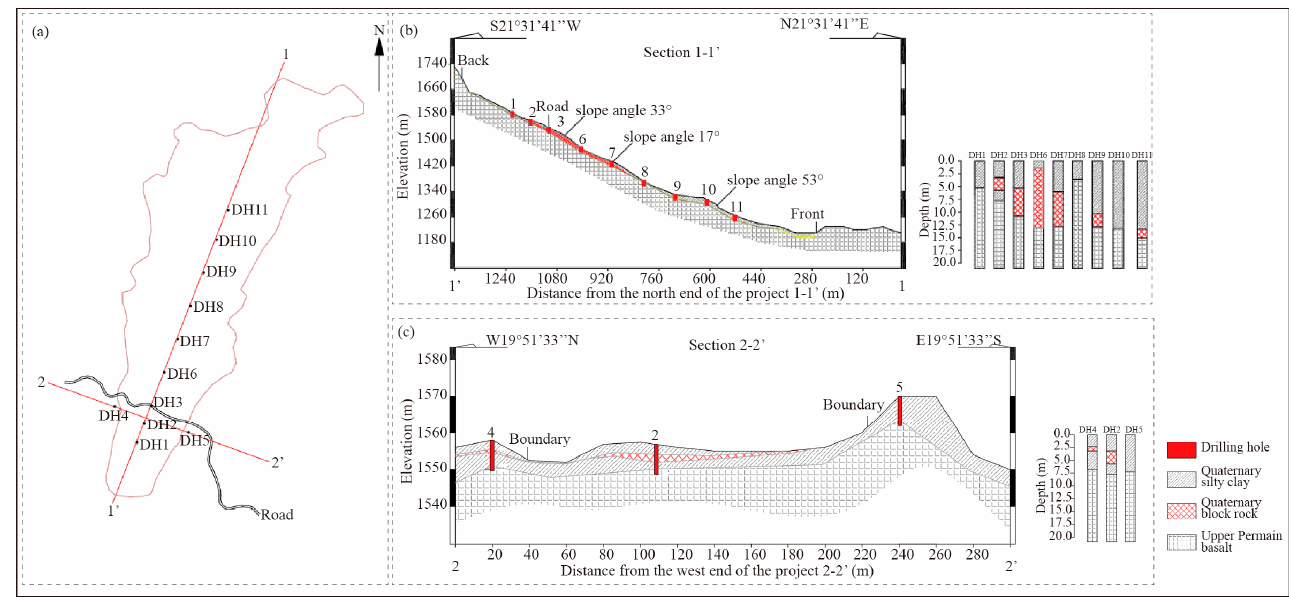
Figure 6. Geological cross ‐ section of the Shuicheng landslide revealed by boreholes. ( a ) Location of of boreholes; ( b ) Section along 1–1’ (sliding direction of the landslide, see ( a ) for the position of the boreholes; ( b ) Section along 1 – 1’ (sliding direction of the landslide, see ( a ) for the position of the section); ( c ) Section along the 2–2’ section (perpendicular to the sliding direction of the landslide; section); ( c ) Section along the 2 – 2’ section (perpendicular to the sliding direction of the landslide; see ( a ) for the position of the section); DH: drilling hole.